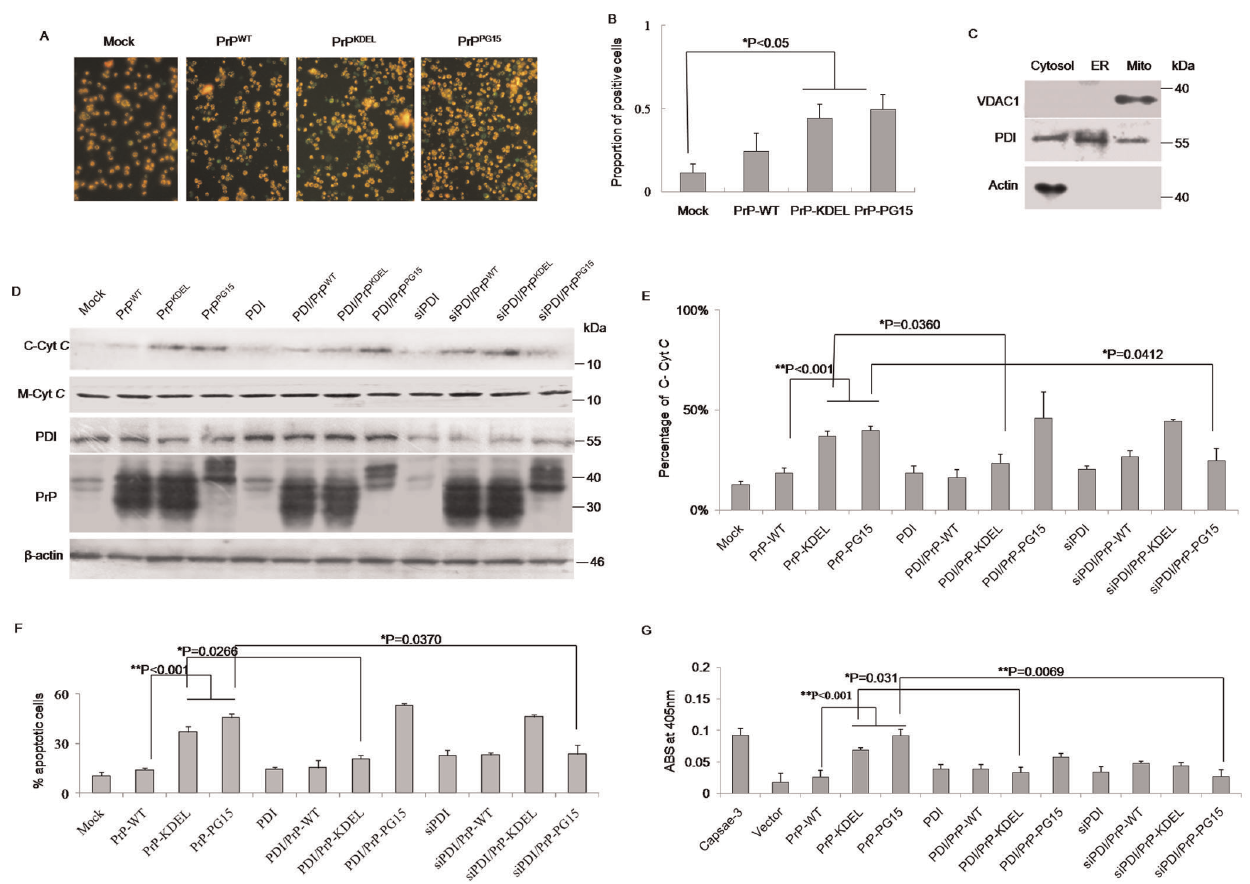
Figure 6. Assays of mitochondrial dysfunction in the cells expressing various PrP constructs under the condition of overexpression of PDI or knockdown of endogenous PDI. A. Images of the cells with abnormal mitochondrial transmembrane potentials under a fluorescence microscopy. Cells under apoptotic process are colored as green and alive cells are red ( 6 200). B. Quantificational analysis of the percentages of apoptotic cells among the total cells. Data are calculated from three independent tests and presented as mean values 6 SD. Statistical differences compared with controls are illustrated as *P , 0.05. C. Qualitative evaluation of the prepared cell fractions with Western blots of VDAC1 (mitochondrial maker), PDI (ER maker) and actin (cytosol marker). D. Western blots for C-Cyt C outflux in the cytosol fractions and M-Cty C in the mitochondrial fraction of various preparations. The expressing levels of PDI and PrP in the cell lysates of various preparations were also evaluated with individual Western blots. E. Quantitative analysis of C-Cyt C with normalizing for mitochondrial membrane-associated Cyt C . Data are calculated from three independent tests and indicated as mean values 6 SD. Statistical differences compared with controls are illustrated as *P , 0.05 or **P , 0.001 F. Cytoflowmetry analysis of the cells with mitochondrial dysfunction each preparation with a mitochondrial apoptosis detection kit. The percentages of apoptotic cells are shown in Y-axis. Data are calculated from three independent tests and indicated as mean values 6 SD. Statistical differences compared with controls are illustrated as *P , 0.05 or **P , 0.001. G. Caspase-3 activity assays of various preparations with a commercial kit. 2 U/ m l of recombinant human capsase-3 (marked as Caspase-3) supplied in the kit was used as the positive control. ABS indicates as absorbance at 405 nm. Data are calculated from three independent tests and indicated as mean values 6 SD. Statistical differences compared with controls are illustrated as *P , 0.05 or **P , 0.001.